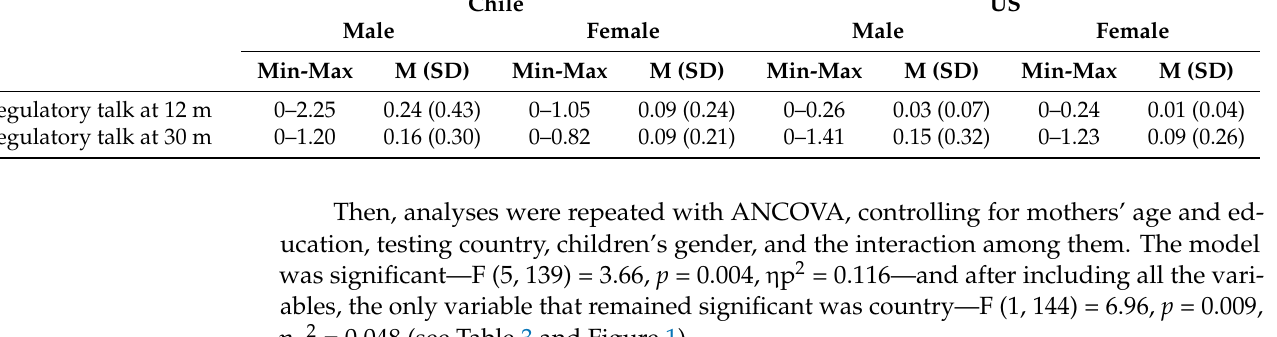
Table 2. Descriptive statistics for mothers’ regulatory talk at 12 and 30 months, considering country and children’s gender. Chile US Male Female Male